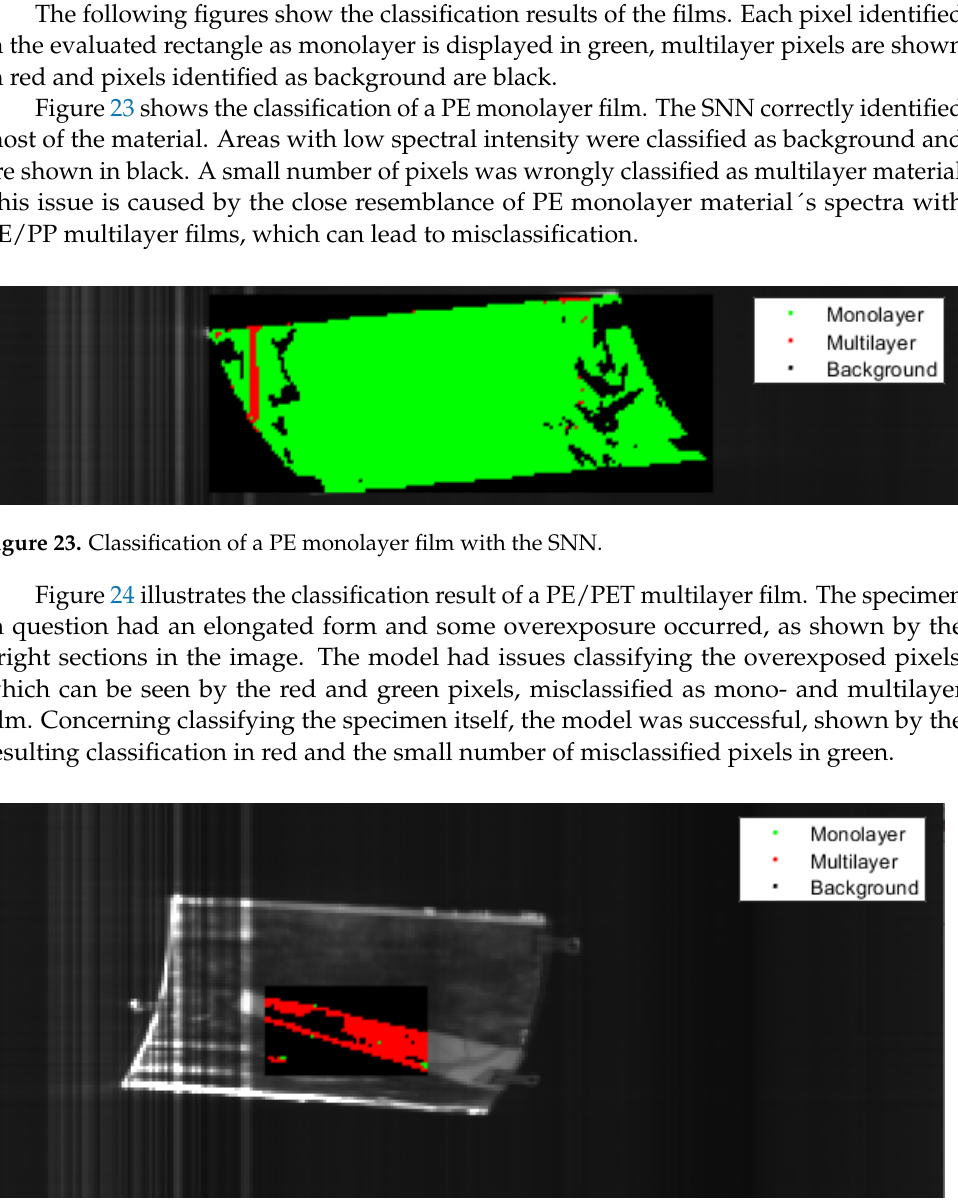
Figure 25. Classification of PE/PP multilayer film with the SNN. Figure 26 shows the unclassified specimen and the classification result of the multi- layer cheese packaging. The neural network had issues with the low intensity of the re- cording in some areas, shown by the large proportion of pixels classified as background in black. The neural network correctly classified most of the specimen´s pixels where the intensity was sufficient for classification. Only a minuscule number of pixels were wrongly classified as monolayer pixels, shown by the green pixels in the classified image.